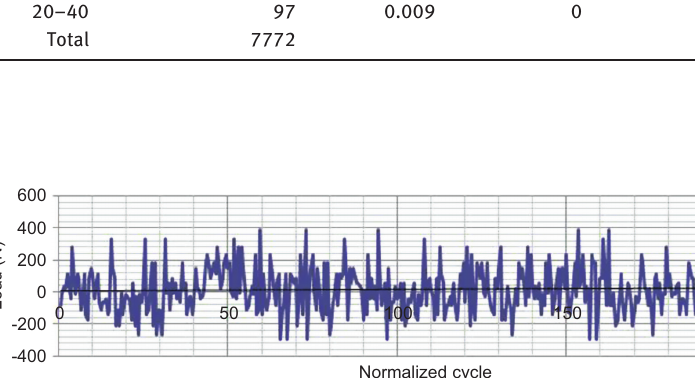
Figure 13 Normalized load spectrum calculated by the proposed load spectrum estimation